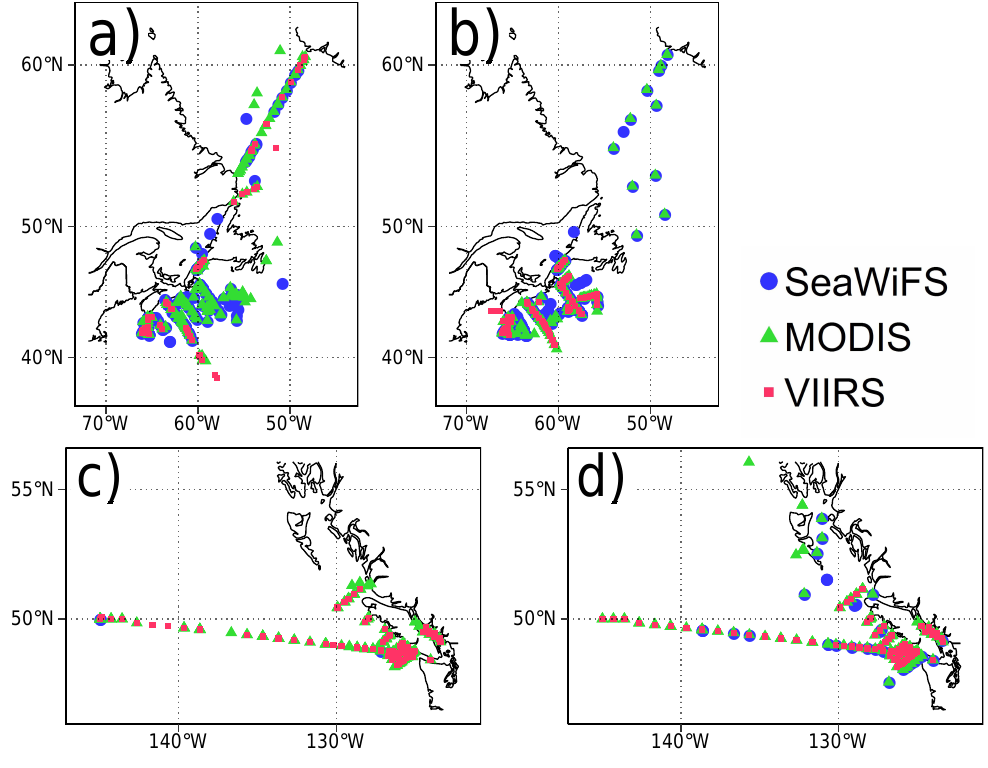
Figure 1. Locations of satellite matchups ( a ) in the Northwest Atlantic (NWA) from January to June, ( b ) from July to December, ( c ) in the Northeast Pacific (NEP) from January to June, and ( d ) from July to